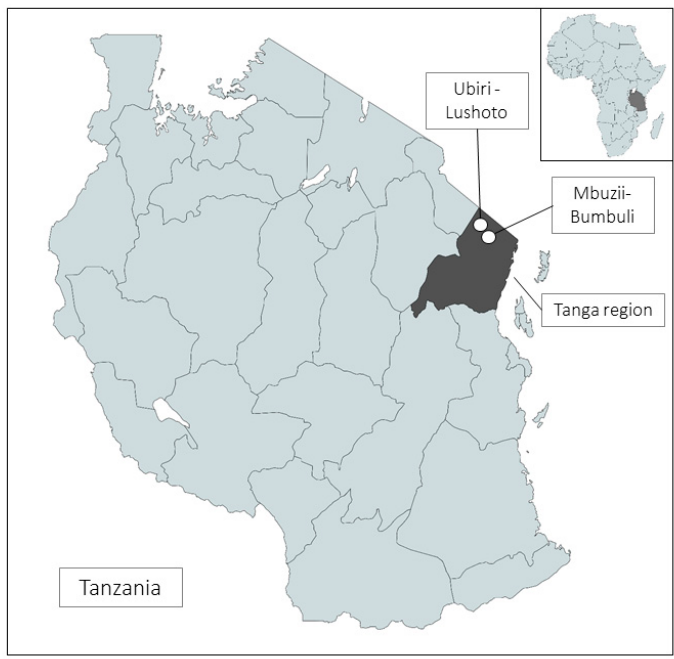
Figure 1. Case study location: two villages (Ubiri and Mbuzi(i)), the Tanga region, Tanzania .